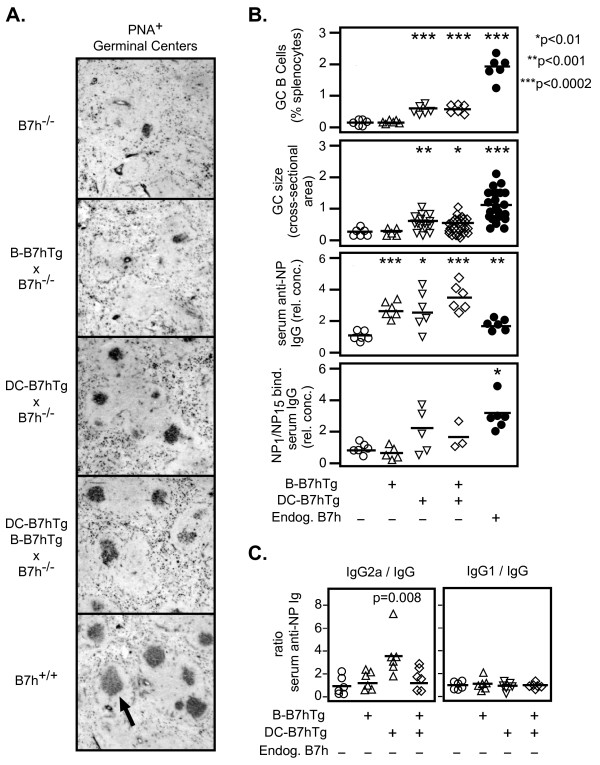
B7h expression on DCs, but not plasma B cells, contributes to germinal center formation and enhances IgG2a isotype usage. Transgenic mice on the B7h−/− background were immunized with NP-CGG in alum, and analyzed after 14–21 days. (A) Splenic cryosections were analyzed by immunohistochemistry on day 14 to reveal PNA+ germinal centers (indicated by arrow). Images are representative of larger fields shown in Additional file 2: Figure S2. Original total magnification was 64X. (B) The number of germinal center B cells measured by flow cytometry, the relative cross-sectional area of germinal centers determined by imaging, and serum anti-NP IgG responses measured by ELISA at day 14 are shown. The relative affinities of serum anti-NP antibody responses were measured by the ratio of NP1/NP15-binding serum IgG on day 21. (C) The ratios of NP-specific IgG2a and IgG1 to total NP-specific IgG in serum on day 14, determined by ELISA, are shown. For ELISA and flow cytometry data, each symbol represents an individual immunized mouse. For GC size analysis, each symbol represents an individual germinal center. The mean of each group is indicated by a solid bar, and p values are shown where significance was detected (Student’s t test, p < 0.05) between the B7h−/− group and transgenic or B7h+/+ groups. For ELISA data, the mean values from control B7h−/− groups were set to a value of 1. The data are representative of three independent experiments.